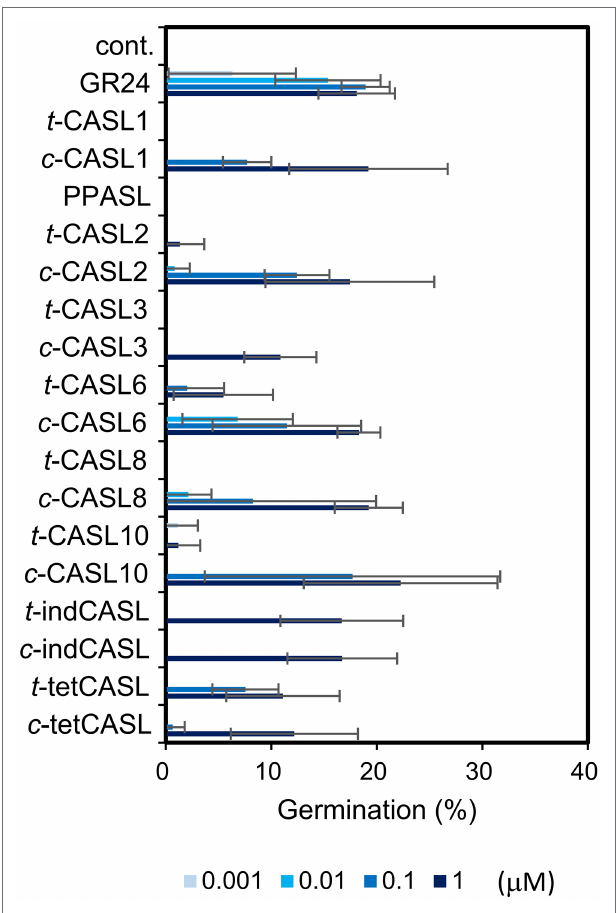
FIGURE 5 | Germination inducing activity of CASLs toward Striga hermonthica seeds. Data are the means ± SD ( n = 3). cont. means control with only acetone at 0.01%.